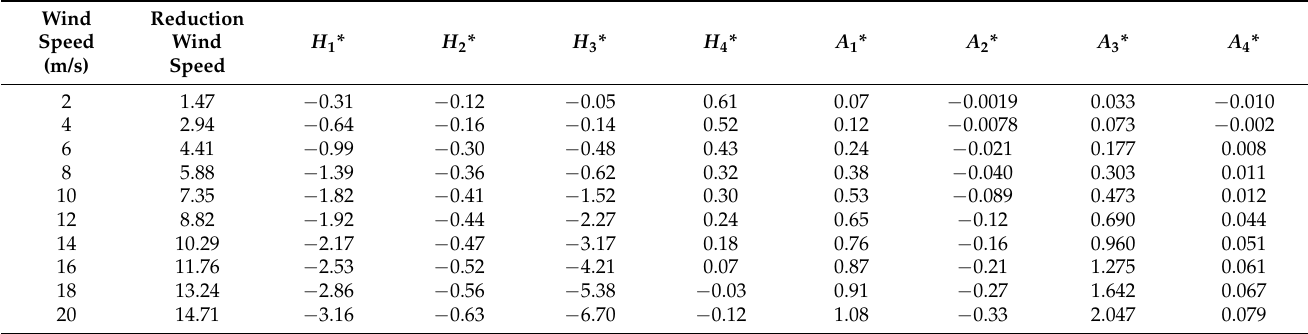
Table 3. Flutter derivatives of Xiangshan Harbor Bridge.